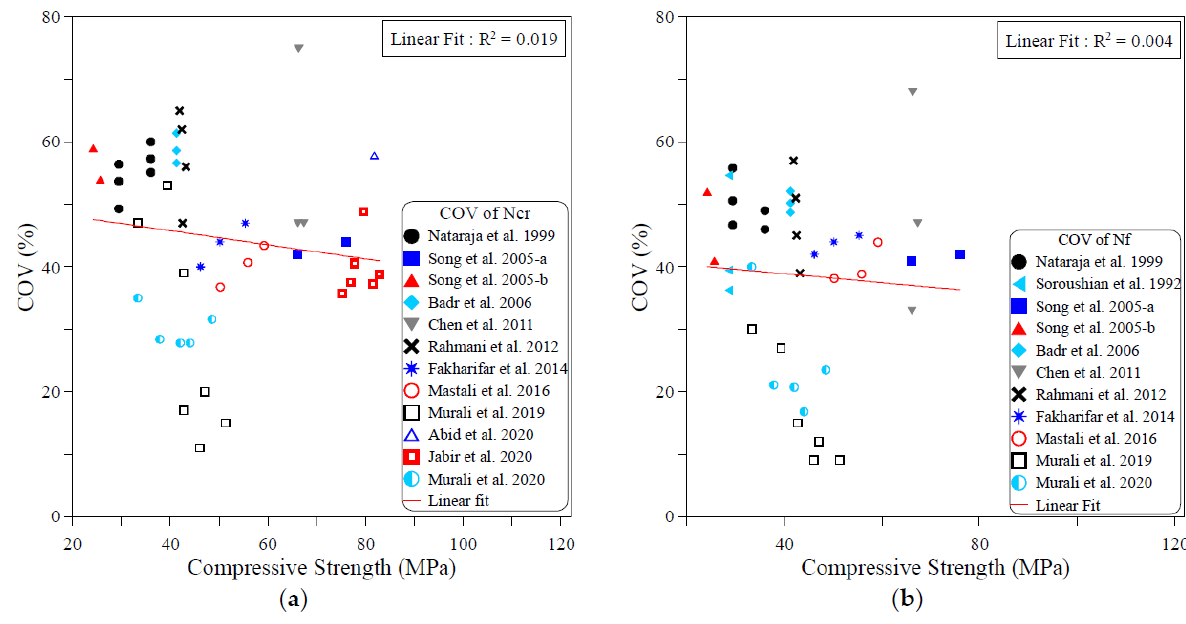
Figure 1. Effect of compressive strength on the scattering of impact results at ( a ) cracking and ( b ) failure.